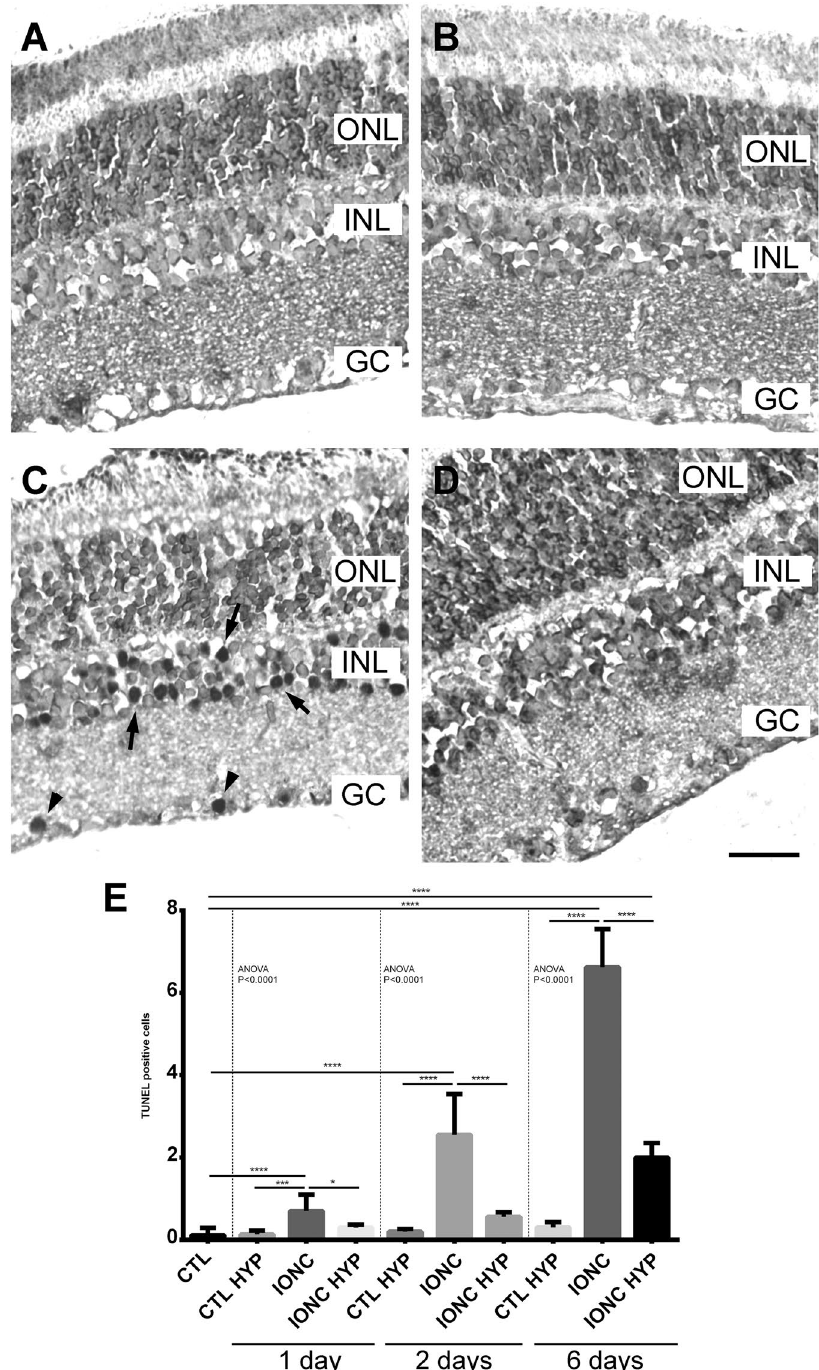
Figure 6. TUNEL positive cells in the 4 experimental groups 6 days post surgery. Representative images of retinas from sham-operated ( A ), sham-operated treated with hypothermia ( B ), IONC-operated ( C ), and IONC-operated rats treated with hypothermia ( D ). TUNEL positive cells were found mainly in the ganglion cell (GC) layer (arrowheads) and in the inner nuclear layer (INL, arrows). ONL: outer nuclear layer. Bar = 50 µ m. Quantification of the results at 3 time points after surgery are shown as histograms ( E ). Bars represent the mean ± SD of all samples (n = 5 per group). Asterisks represent statistically significant differences. * p < 0.05; *** p < 0.001; **** p <